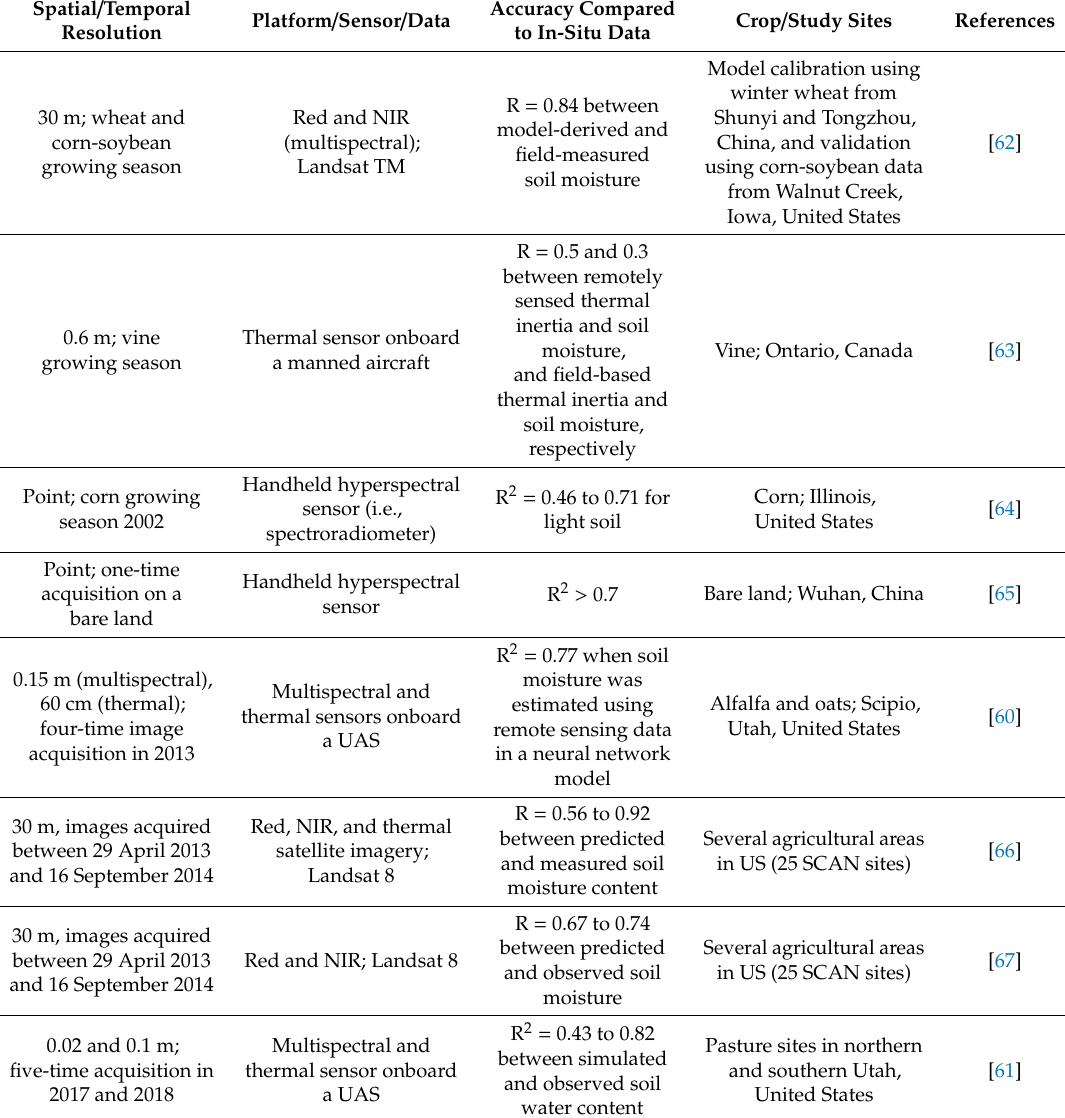
Table 3. Studies focused on soil moisture assessments using RS data from multiple